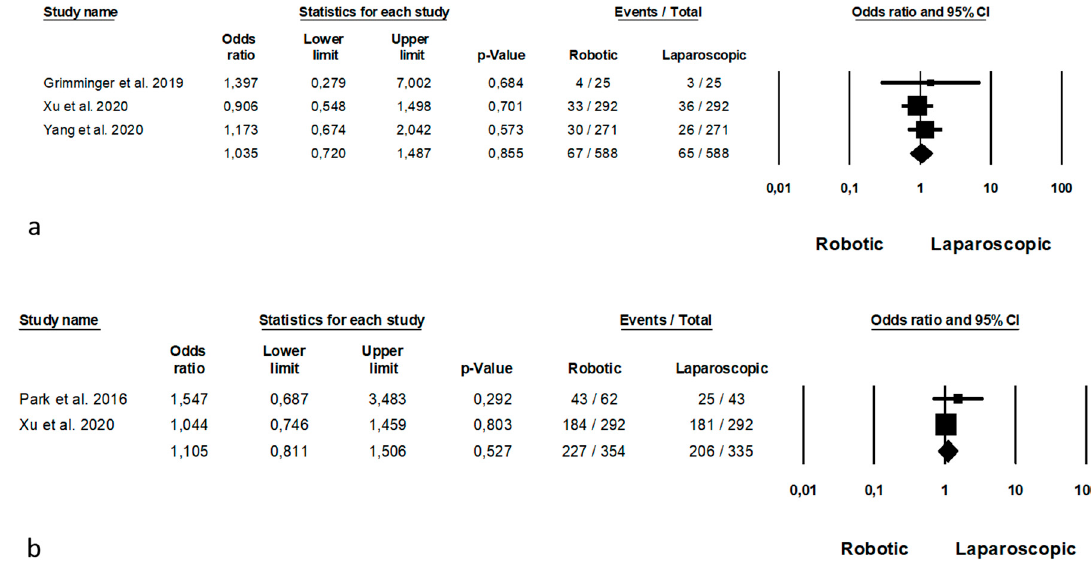
Figure 6. Robotic versus laparoscopic surgery: long-term outcomes. ( a ) recurrences; ( b ) 5-years overall survival.